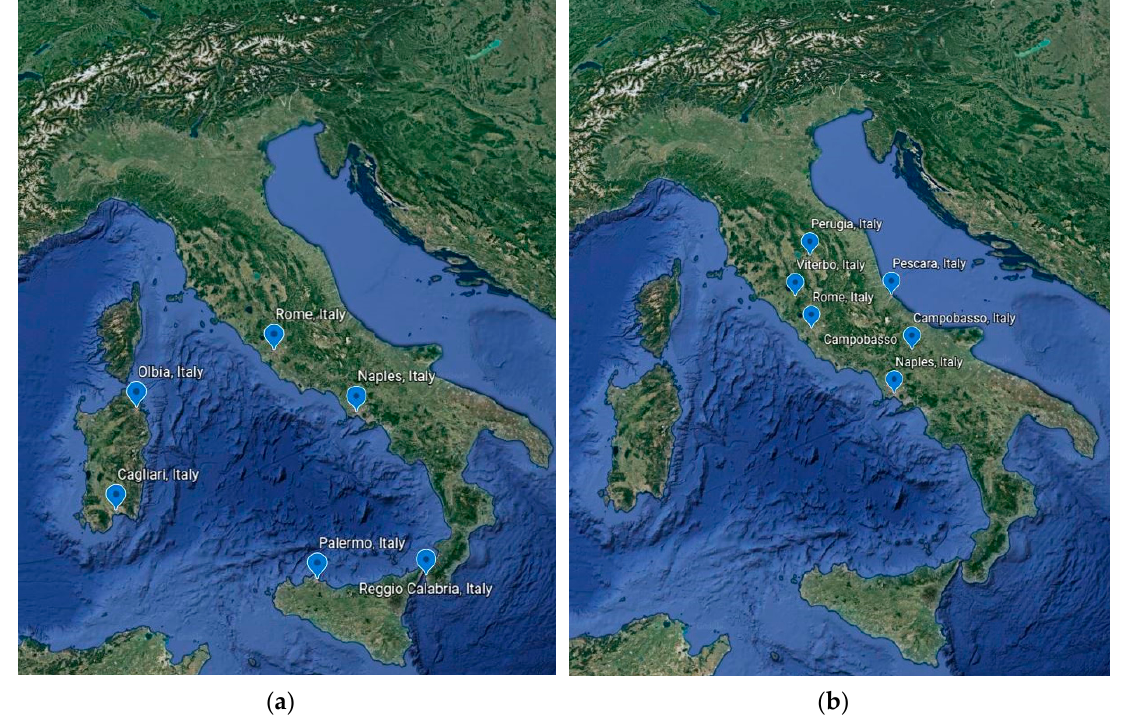
Figure 9. Example Time Difference of Arrival (TDOA) network configurations to be evaluated. Plot ( a ) shows Configuration 1, plot ( b ) shows Configuration 2.